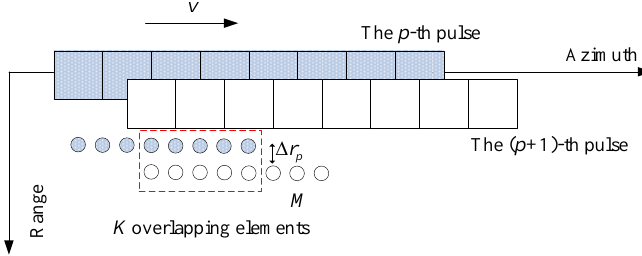
Figure 17. The heave between successive pulses.